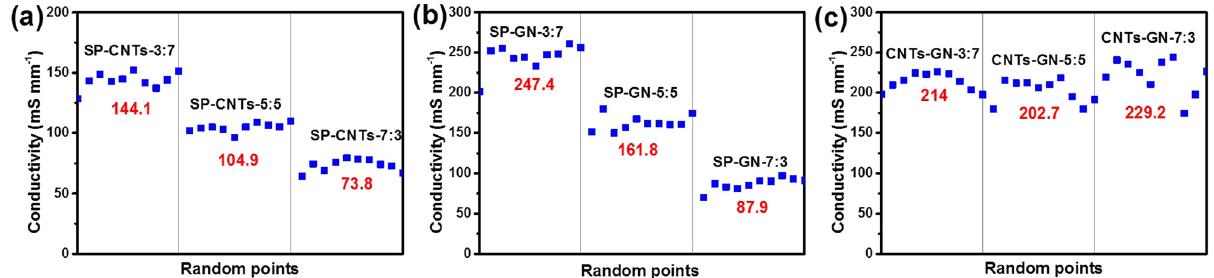
Figure 8: The electrical conductivity plots of the LiFePO 4 cathodes with di ff erent binary conductive agents: ( a ) SP - CNT, ( b ) SP - GN, and ( c ) CNT -